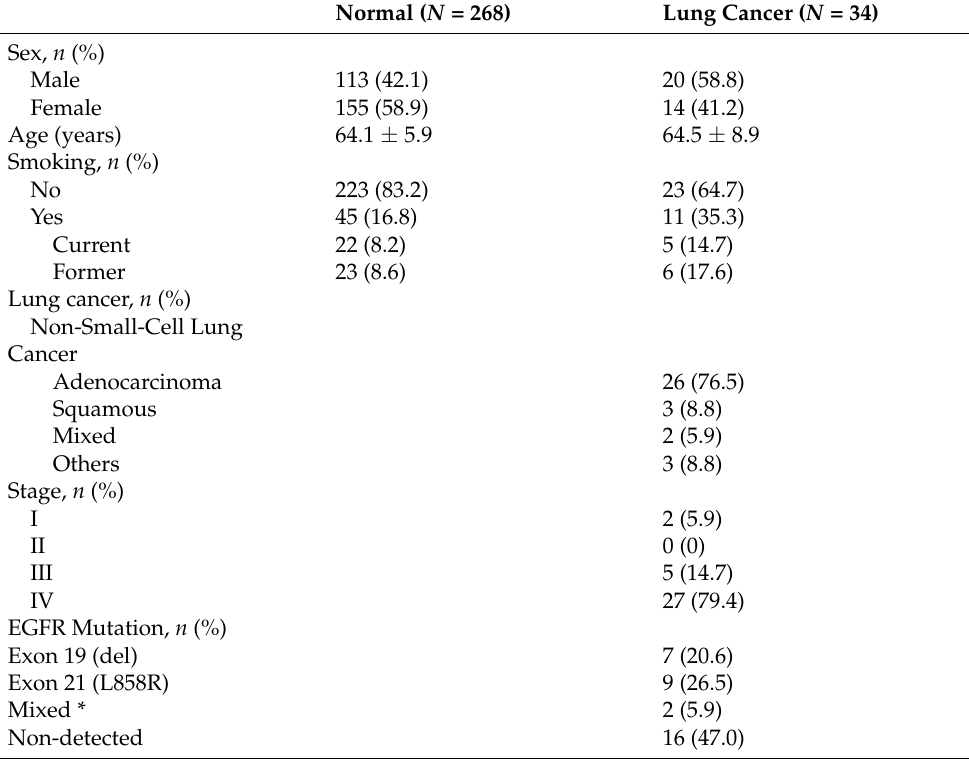
Table 1. Demographic characteristics of the lung cancer patients and normal